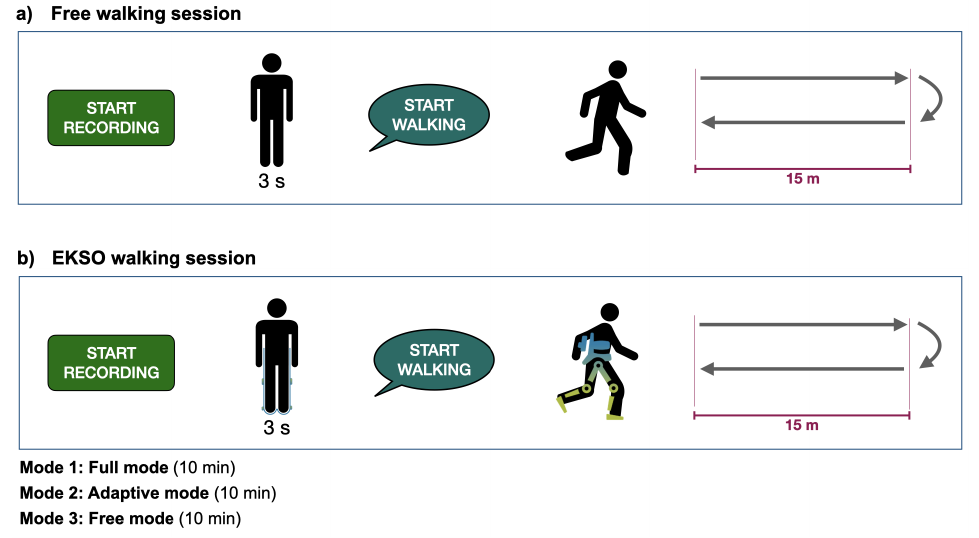
Figure 2. Walking trials: ( a ) Free walking; and ( b ) EKSO walking.